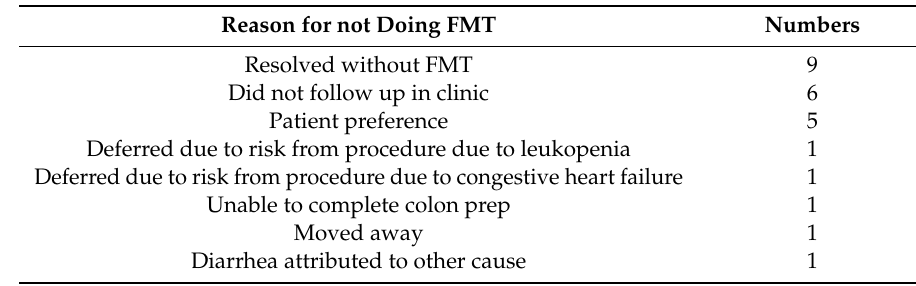
Table 4. Reasons for not pursuing fecal microbiota transplantation (FMT) in patients with ≥ 3 Clostridioides di ffi cile infections (CDI)